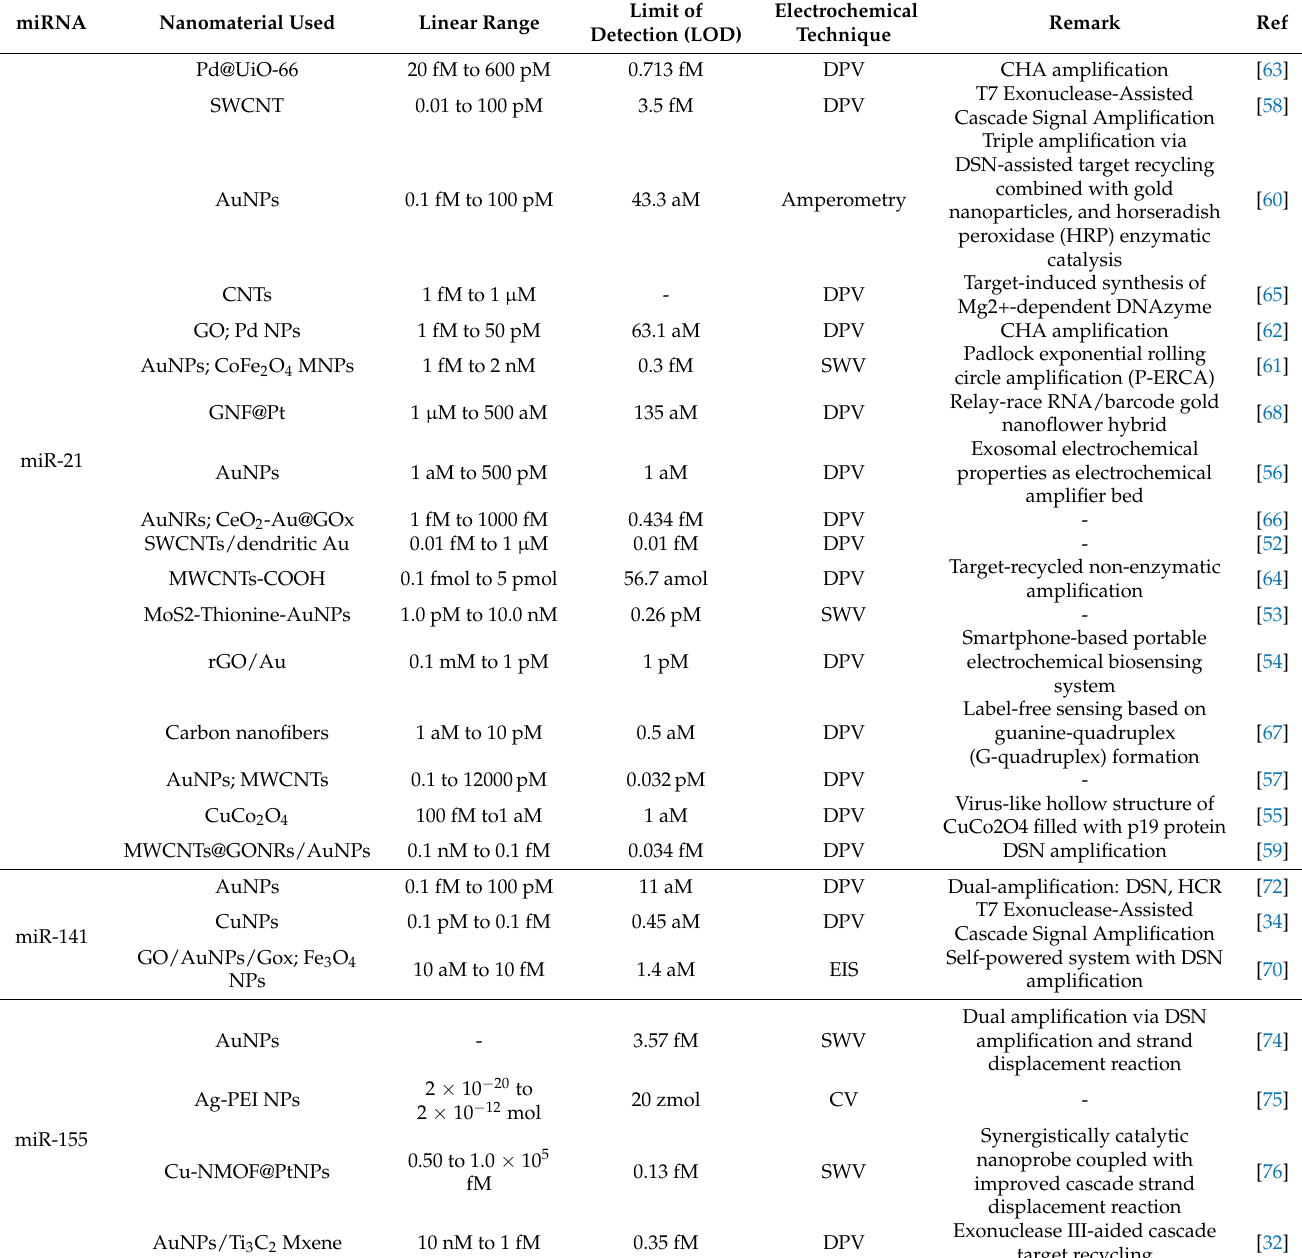
Table 1. Sensing performances of nanomaterial-modified electrochemical biosensor for the detection of miRNAs. miRNA Nanomaterial Used